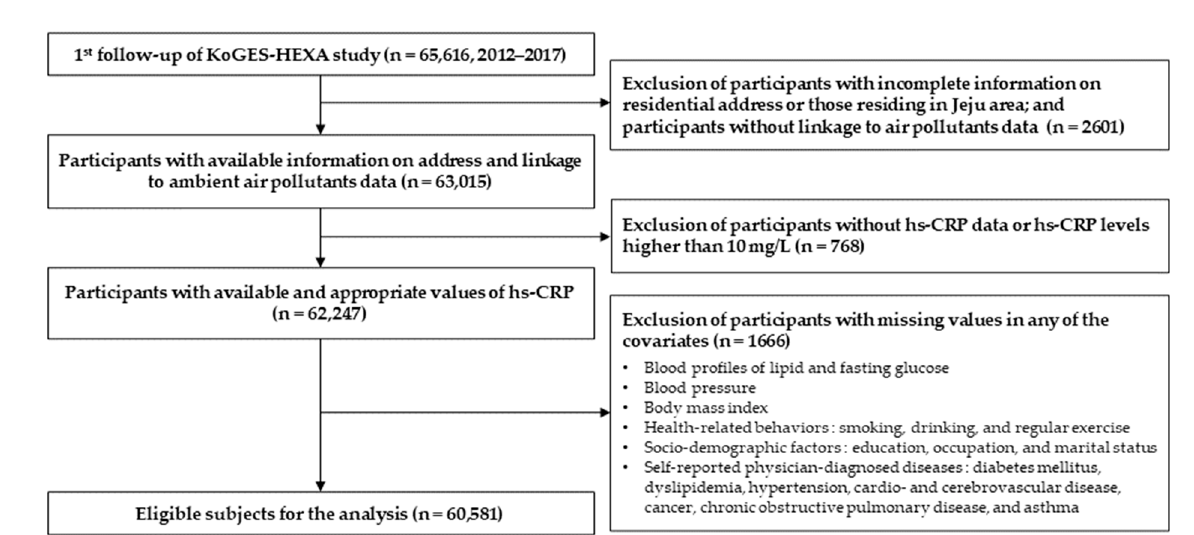
Figure 1. Flow chart of the study participants.